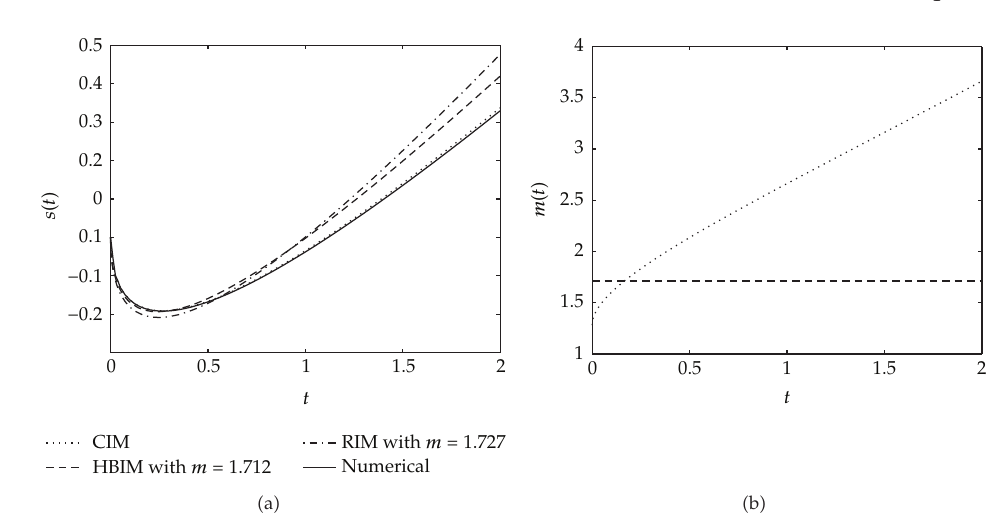
Figure 7: Plots of s against t (cid:3) a (cid:4) and m against t (cid:3) b (cid:4) when β (cid:8)